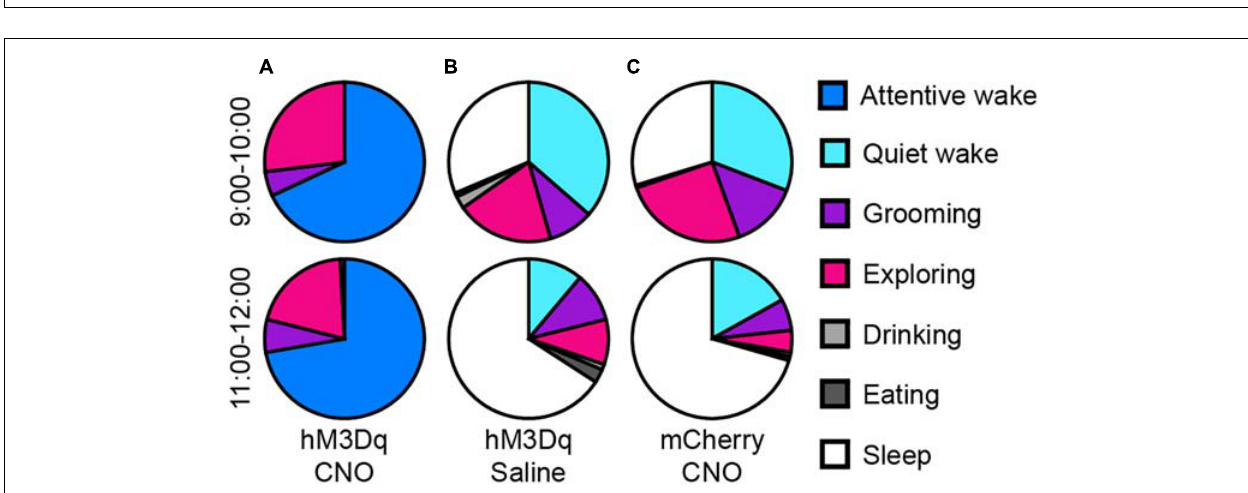
FIGURE 2 | Time course of sleep and power spectra starting 22 h after CNO treatment. (A) No bouts of NREM and REM sleep after the CNO treatment. Each circle represents the hourly mean amount of sleep. The horizontal open and closed bars on the x -axes indicate the 12-h light and 12-h dark periods, respectively. (B) EEG power spectra of NREM and REM sleep during the following day in rats injected with AAV-hSyn-hM3Dq-mCherry in MPB ( n = 8).